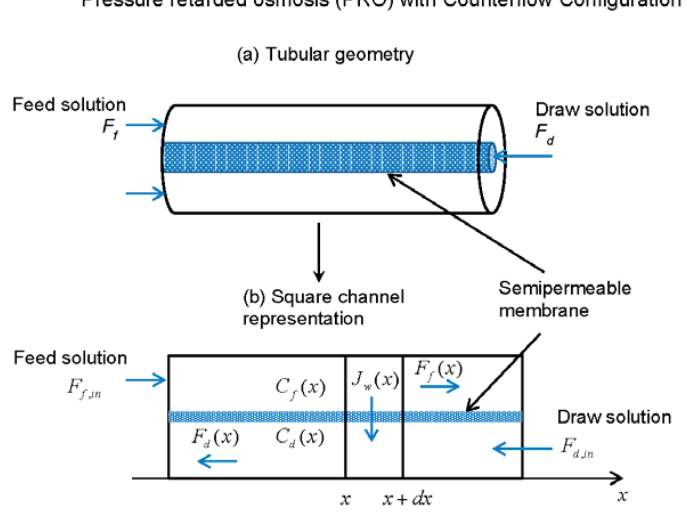
Figure 2. ( a ) A diagram representing tubular geometry and counterflow configuration for PRO. ( b ) Simplified representation of the tubular geometry as a square channel. Concentrations ( C d p x q and C f p x q ) and flows ( J w p x q , F d p x q and F f p x q ) are the functions of the position x along the channel for the counterflow configuration.